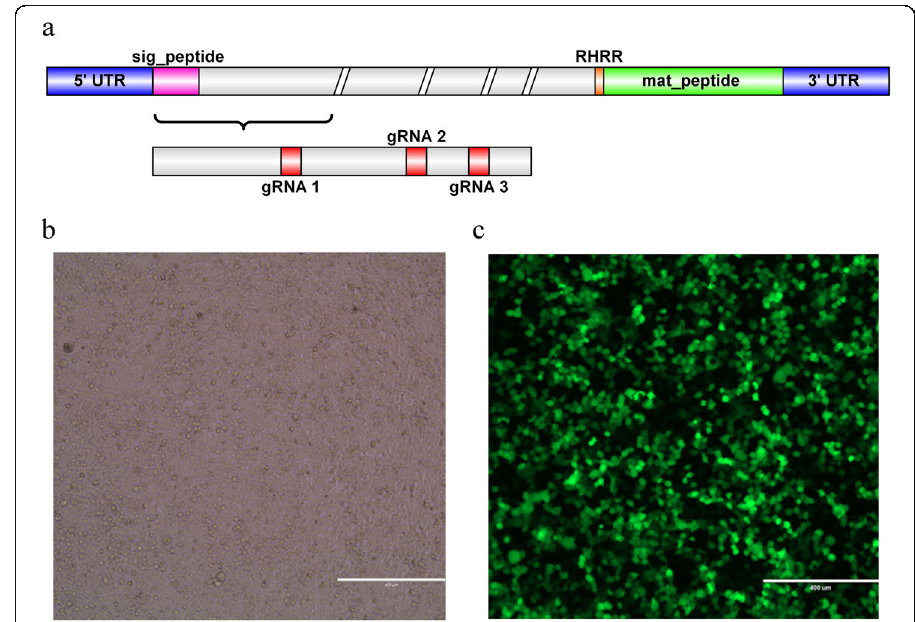
Fig. 1 gRNA design and lentiviral packaging. a – The exons of sika deer TGF- β 1 were analyzed using blast alignment of related sequences, and three gRNA oligonucleotide sequences were designed at the first exon. b – Visible light image of GFP protein. c – Fluorescence image of GFP